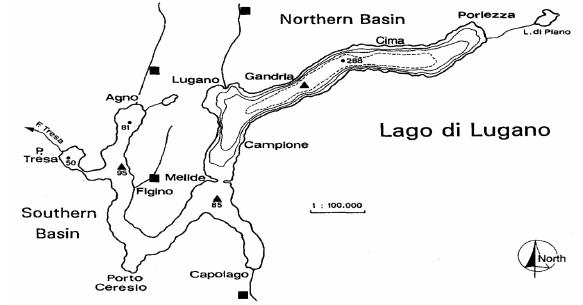
Figure 1. Lake Lugano map (Barbieri and Polli, 1992).